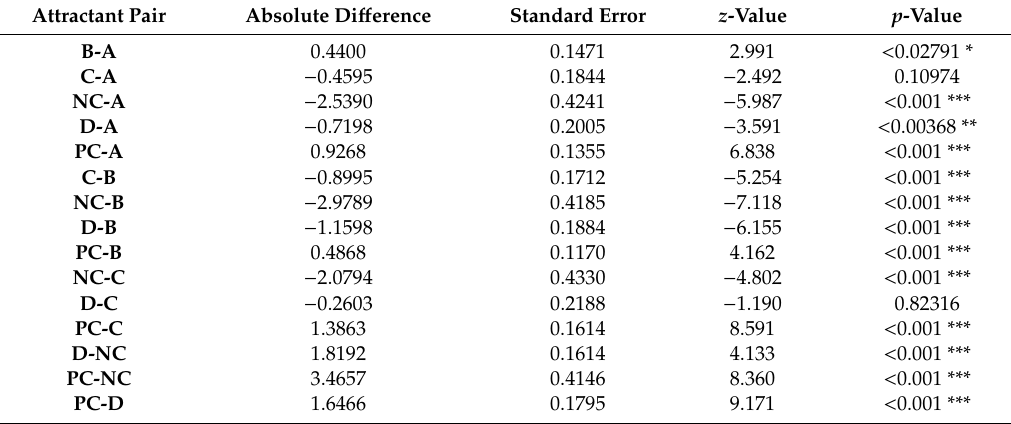
Table 5. Pairwise comparison of attractant e ffi cacy in trapping male H. abietis (based on number of individuals trapped across all localities).